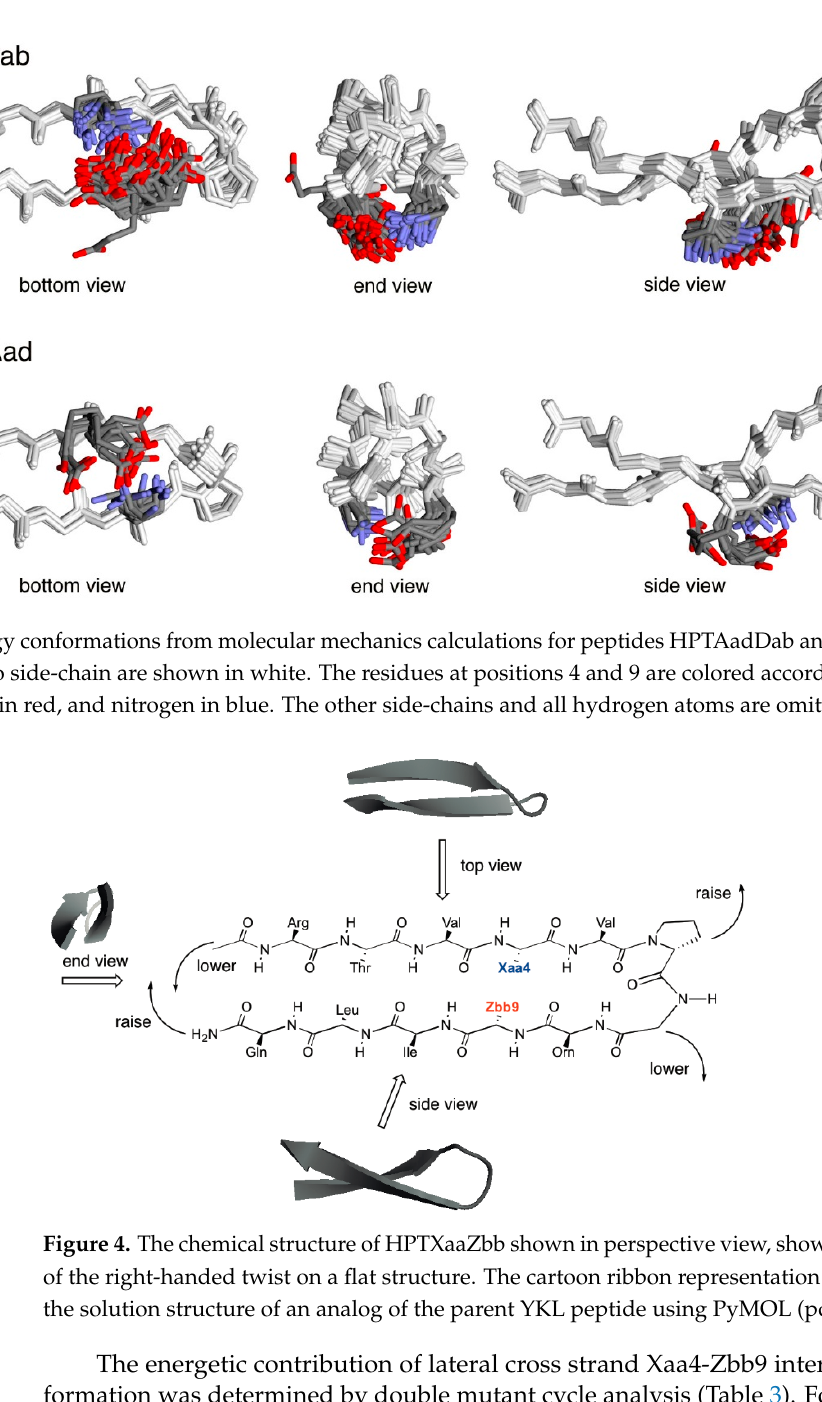
Molecules 2021 , 26 , x FOR PEER REVIEW 9 of 16 swapped Dab4-Aad9 interaction, the unleveled relative positioning exacerbated the